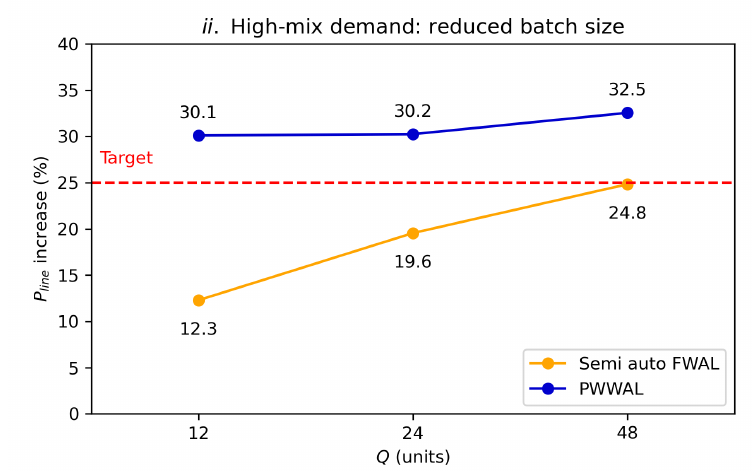
Figure 4. Line productivity improvement of semiautomated FW and parallel walking-worker with respect to manual FW line configuration for reduced batch size ( Q , scenario ii ).